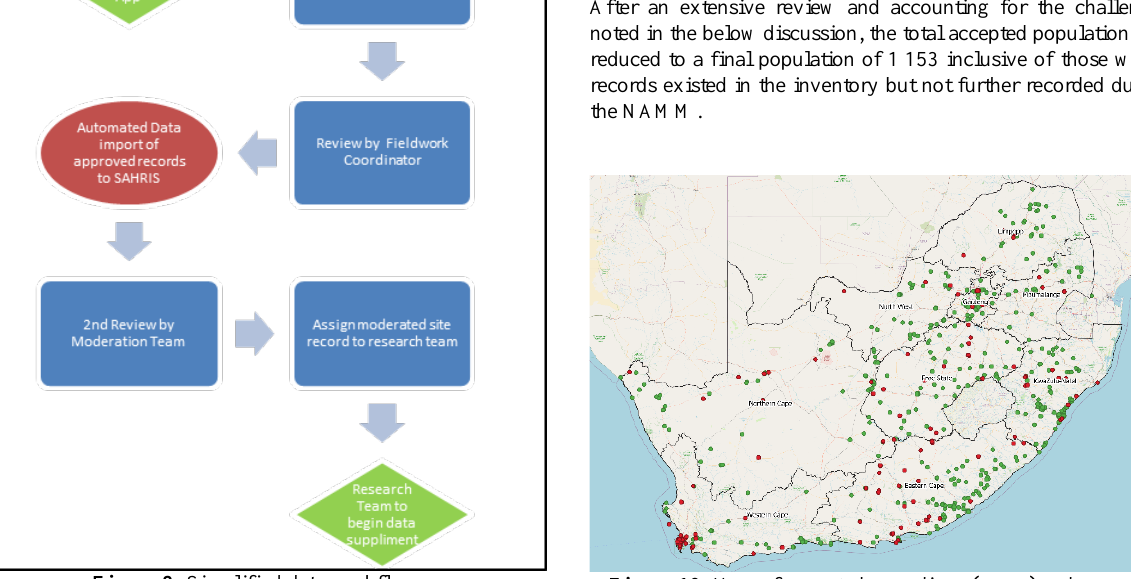
Figure 8: Simplified data workflow